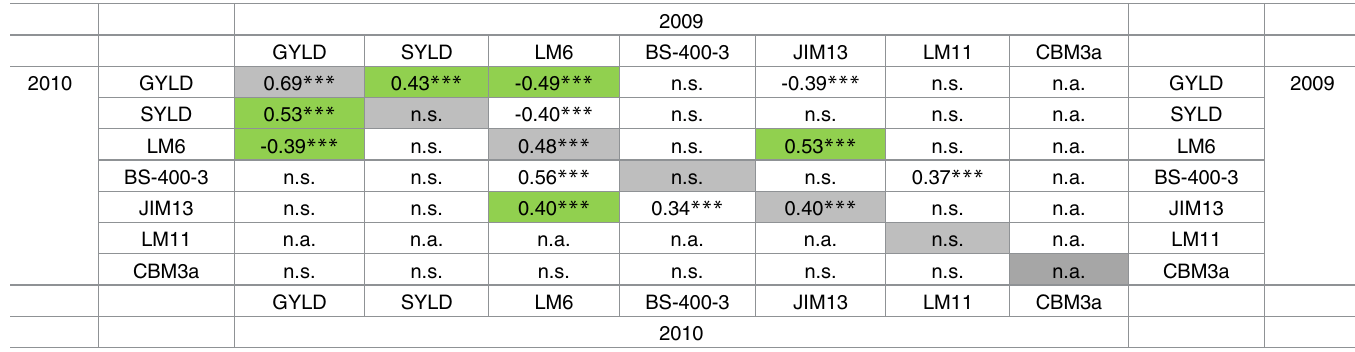
Molecular markers, population structure and LD After filtering the markers, a total of 4976 SNPS were used for subsequent analysis. Of these, 1,284 were recorded as unmapped based on the consensus map used for the present study. Table 2. BLUPS